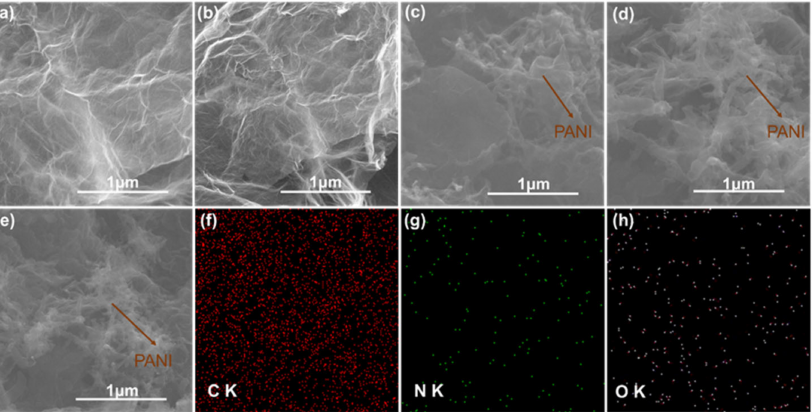
Figure 2. SEM images of the ( a ) GF, ( b ) GF/PPD, ( c ) GF/PANI 5:1 , ( d ) GF/PANI 3:1 , ( e ) GF/PANI 4:1 and ( f ) C, ( g ) N, and ( h ) O element mapping of GF/PANI 4:1